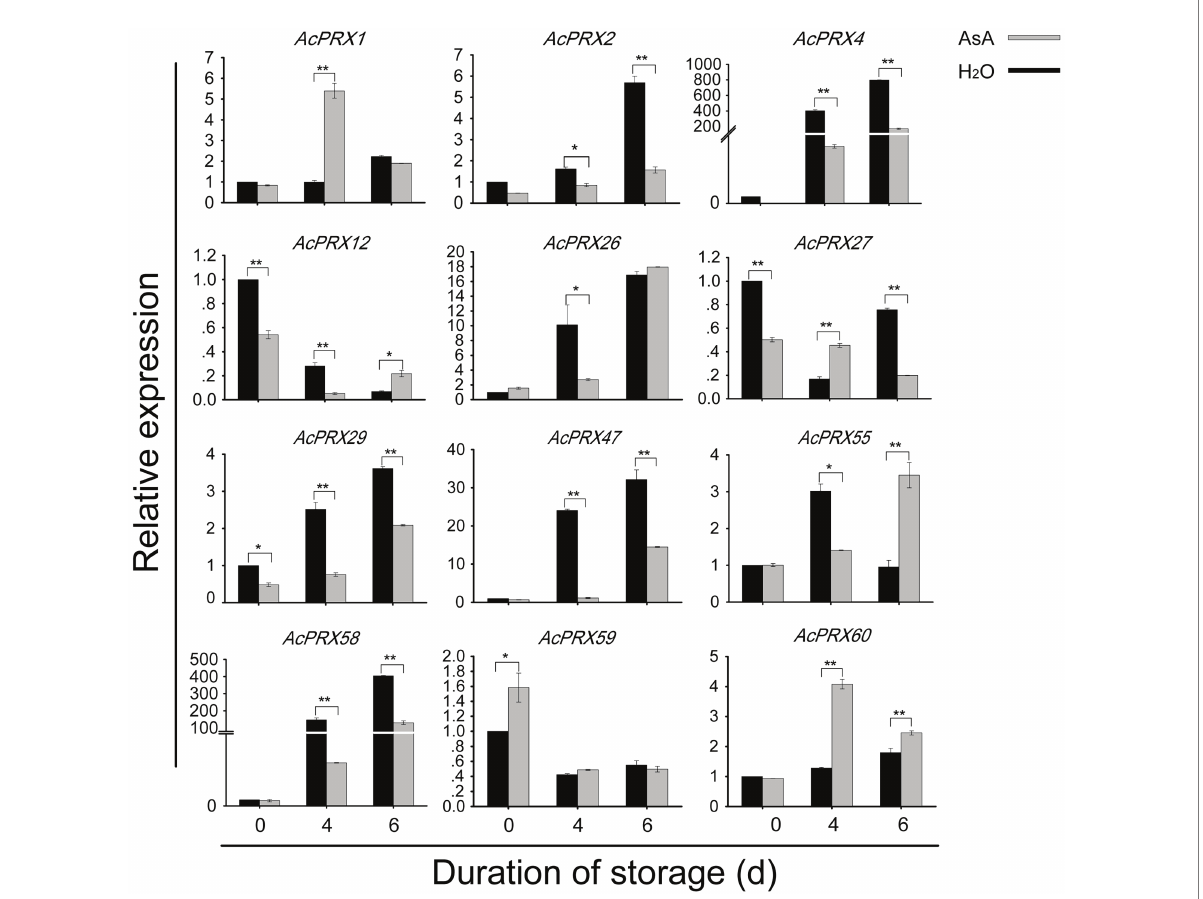
FIGURE 10 Expression of AcPRX genes during pineapple postharvest storage after treatment with ascorbic acid (AsA) or a water control. * p ≤ 0.05, ** p ≤ 0.01 (Student’s t